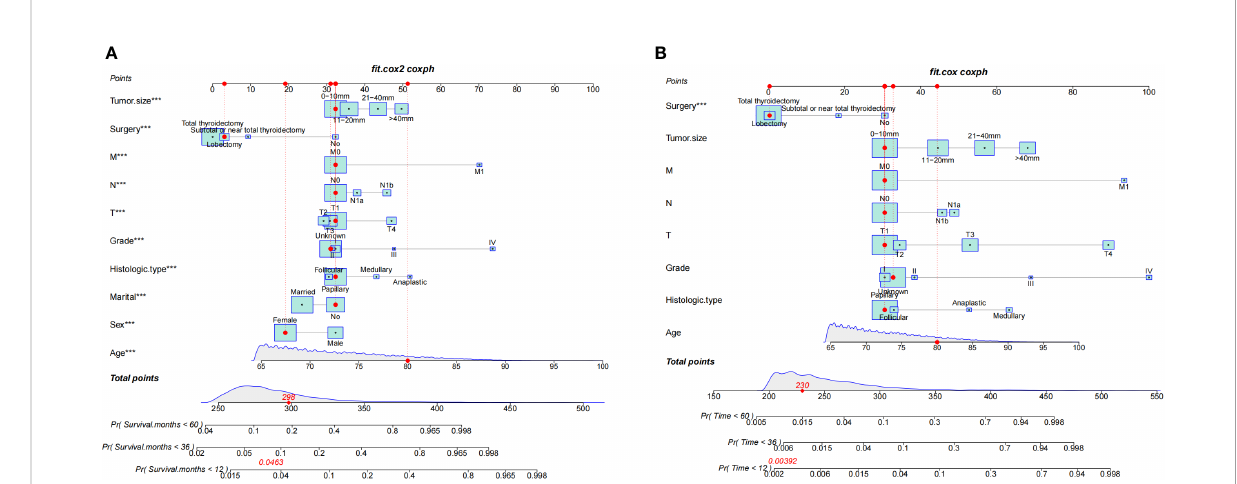
FIGURE 2 Nomograms for 1-, 3-, and 5-year OS (A) and CSS (B) of patients with TC. ***, a highly signi fi cant variable.